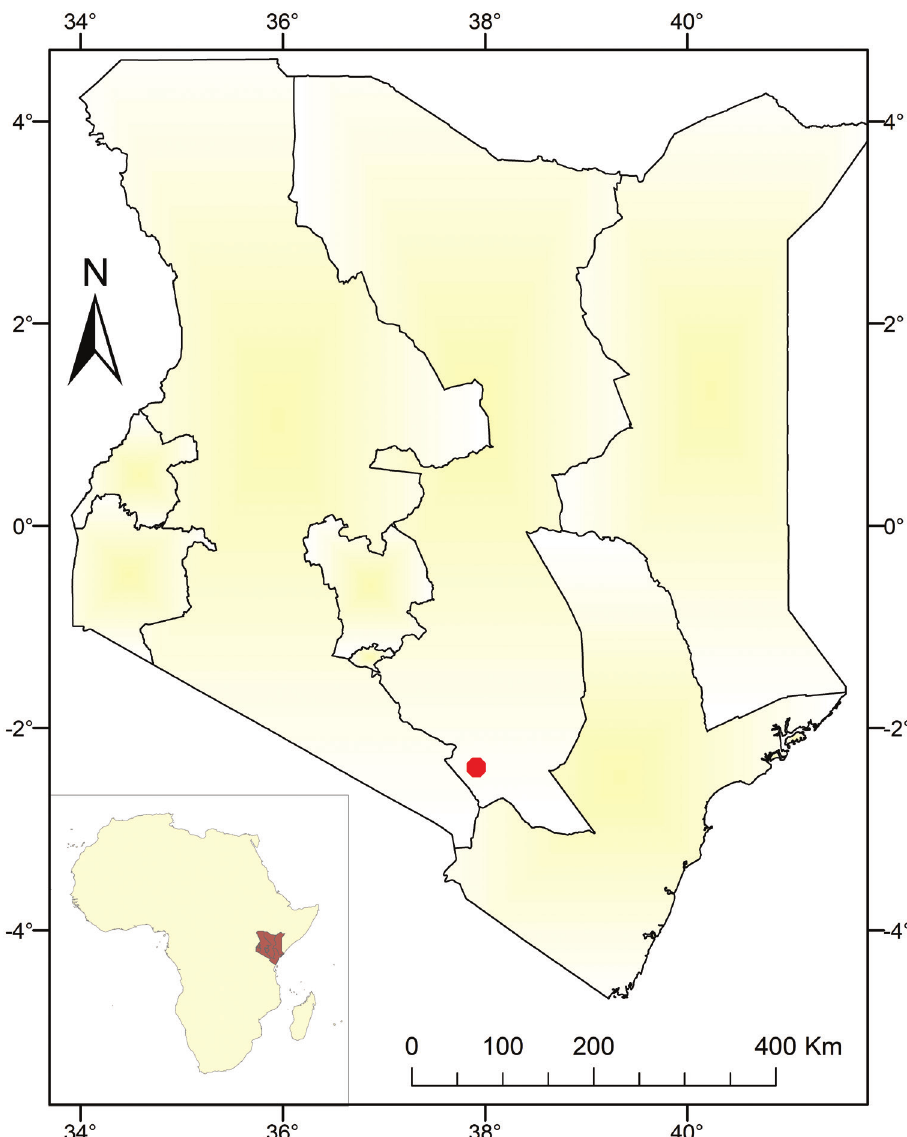
Figure 4. Known distribution of Euphorbia mbuinzauensis in Kenya. The red dot indicates its only known